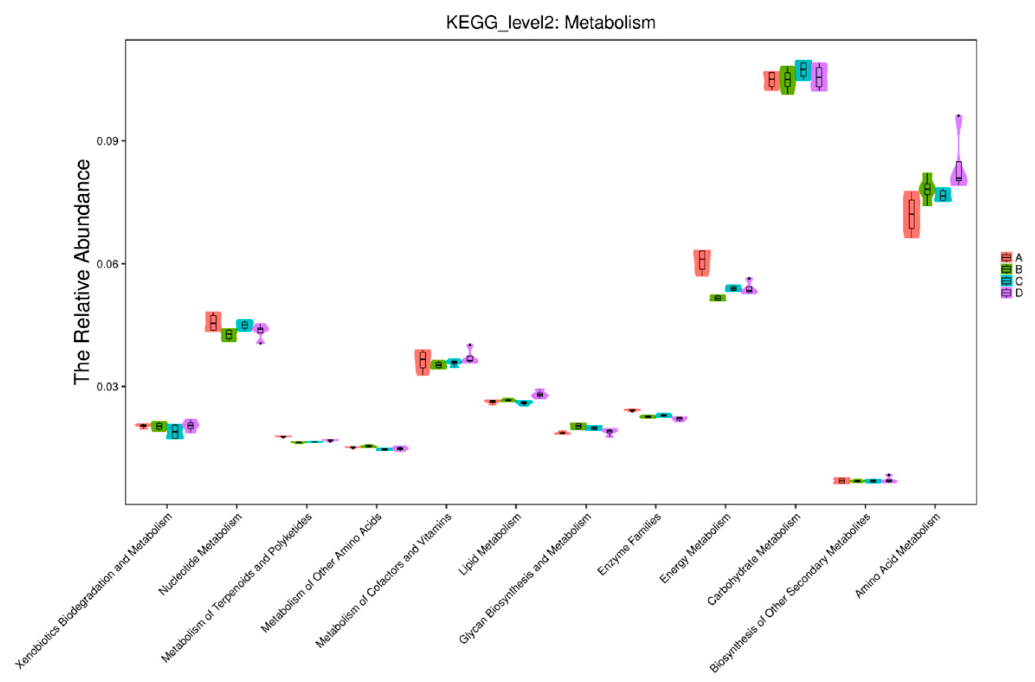
Figure 10. Phylogenetic investigation of communities by reconstruction of unobserved states (PICRUSt) predicted Kyoto Encyclopedia of Genes and Genomes (KEGG) second level distribution map (metabolism). Note: The abscissa is the KEGG second-level functional group, and the ordinate shows the relative abundance of each functional group in each sample (group). A: alfalfa, B: cornstalk, C: rice straw, D: control.